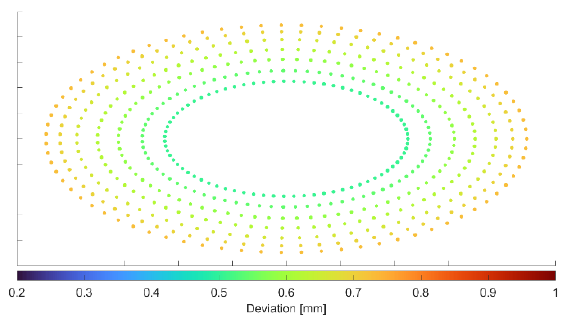
Figure 9 . Accuracy of the different measurement positions after the complete